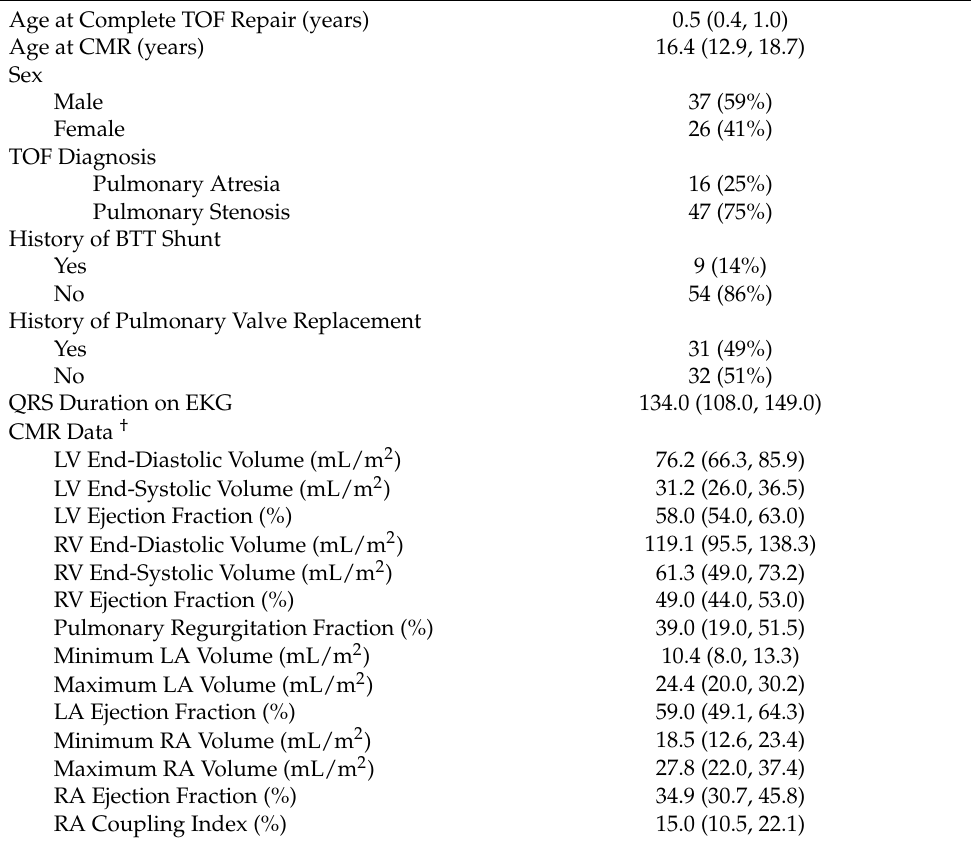
Table 1. Characteristics of the study population (N = 63)